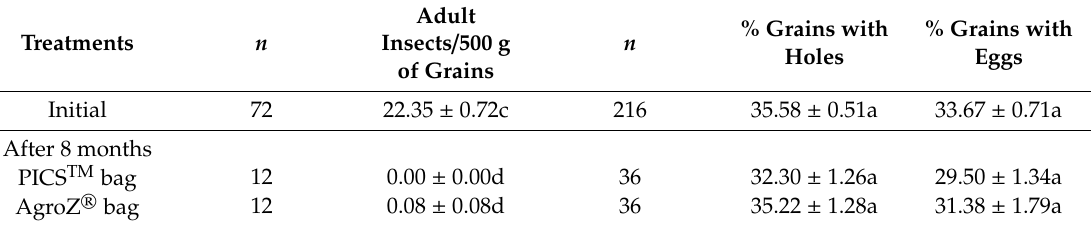
Table 2. Live insect populations (numbers of adults per 500 g of grain), damaged grains (%) and grains with eggs (%) of naturally-infested cowpea stored in hermetic and non-hermetic bags for eight months in Maradi, Niger.